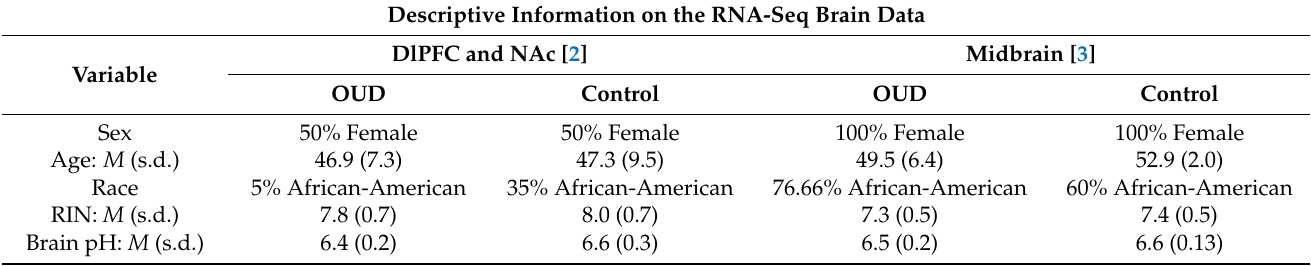
Table 1. Human brain samples of OUD and controls. Descriptive Information on the RNA-Seq Brain